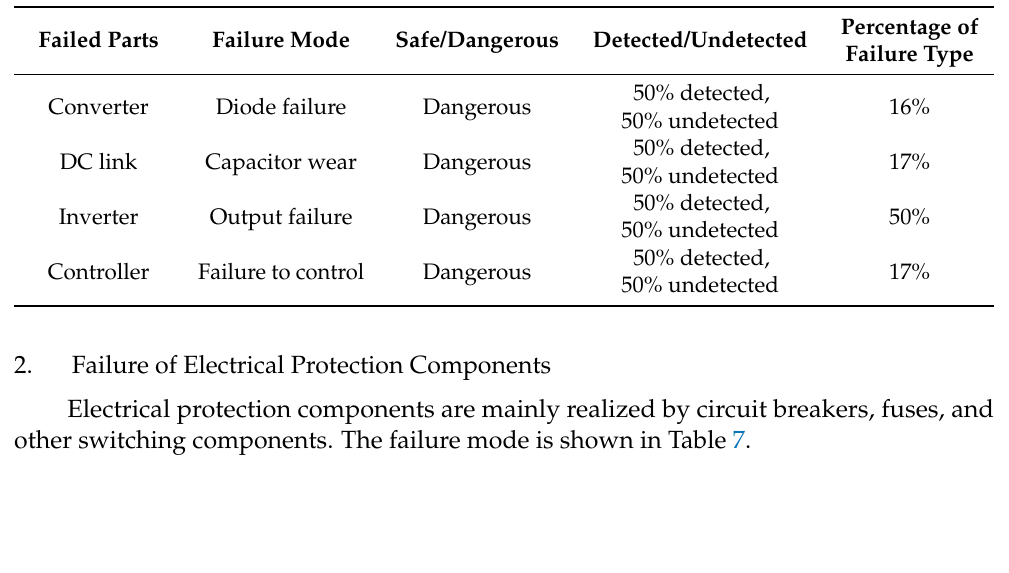
Table 6. Failure mode of frequency